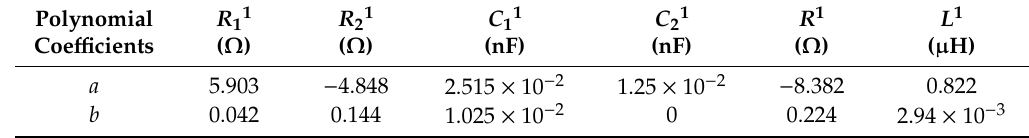
Table 5. Linear parameters for MT2 pi-circuit as a function of soil resistivity.